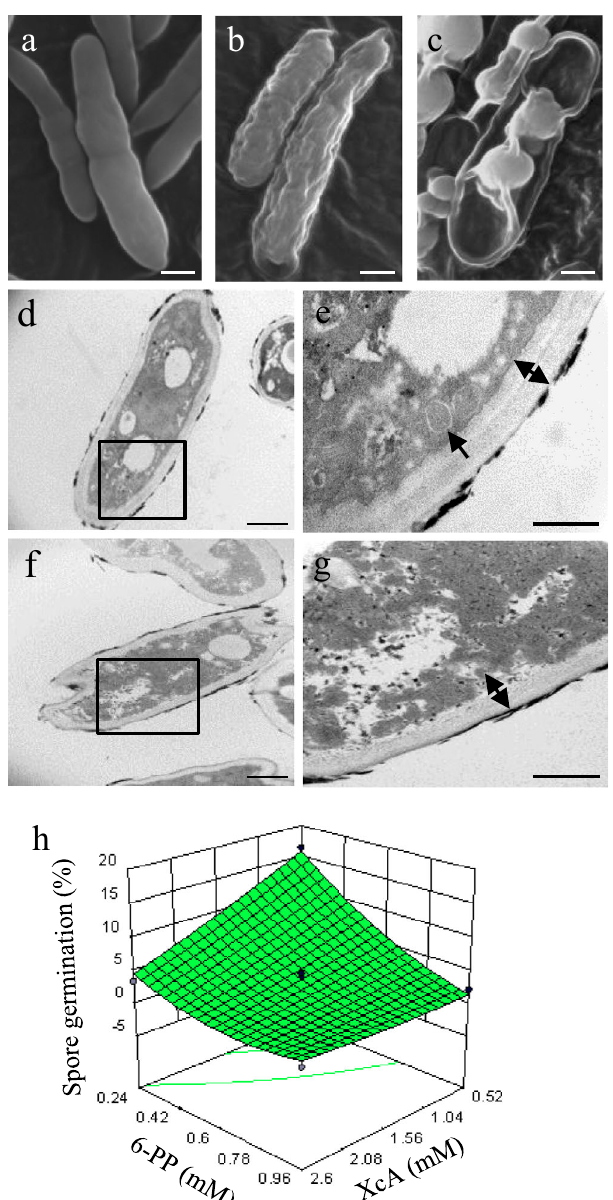
Fig. 2 Xerucitrinin A and 6-pentyl- α -pyrone produced by S. morookaensis strain Sm4-1986 display antifungal activity against Foc TR4. a SEM images showing the morphology of Foc TR4 spores treated by 3 mM xerucitrinin A for 72 h. b SEM images showing the morphology of Foc TR4 spores treated by 0.96 mM 6-pentyl- α -pyrone for 72 h. c Morphology of the normal Foc TR4 spores analyzed by SEM. d Transmission electron microscope (TEM) image of the Foc TR4 spores treated by 0.96 mM 6- pentyl- α -pyrone for 24 h. e Magni fi cation of the squared area in ( d ) showing a massive cytoplasm without integral organelles. The double arrow indicates the thinned cell wall. f TEM image of the normal Foc TR4 spores. g Magni fi cation of the squared area in ( f ) showing mitochondrion (indicated by arrows). The double arrow indicates the thickness of cell wall. h Response surface methodology analysis shows interaction effect of xerucitrinin A and 6-pentyl- α -pyrone on antifungal activity against Foc TR4. Scare bars in ( a – d ), and ( f ), 1 μ m; and in ( e ) and ( g ), 500 nm.